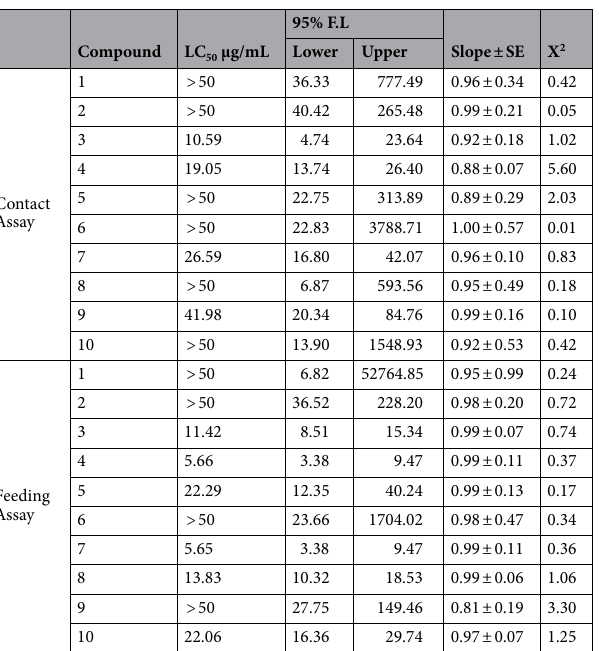
Table 2. Probit analysis of the effects of compounds 1–10 on B. tabaci at 72 h. F.L (Fiducial Limit); X 2 ; (Chi- square); SE (Standard Error); LC 50 (Lethal Concentration).